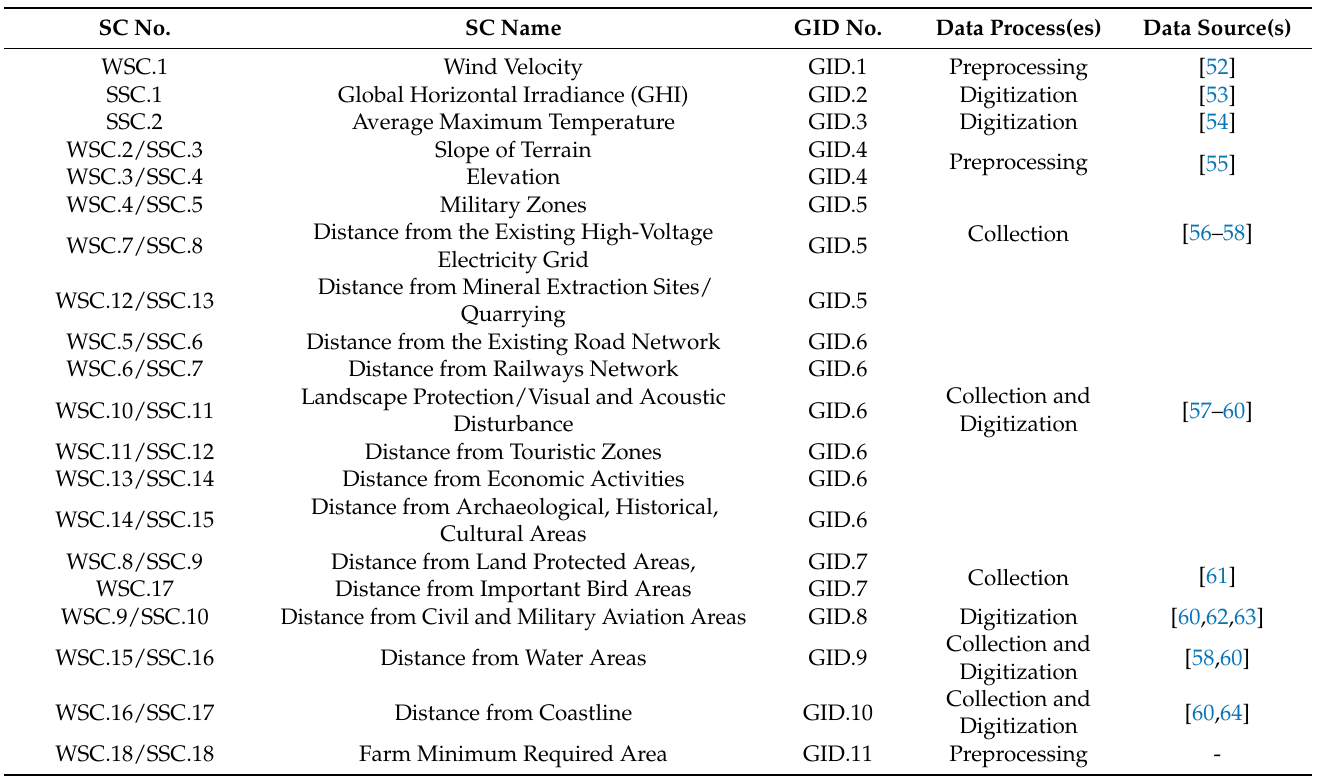
Table 1. Siting Criteria (SC), Geographic Information Datasets (GIDs), data processes, and sources employed in the present